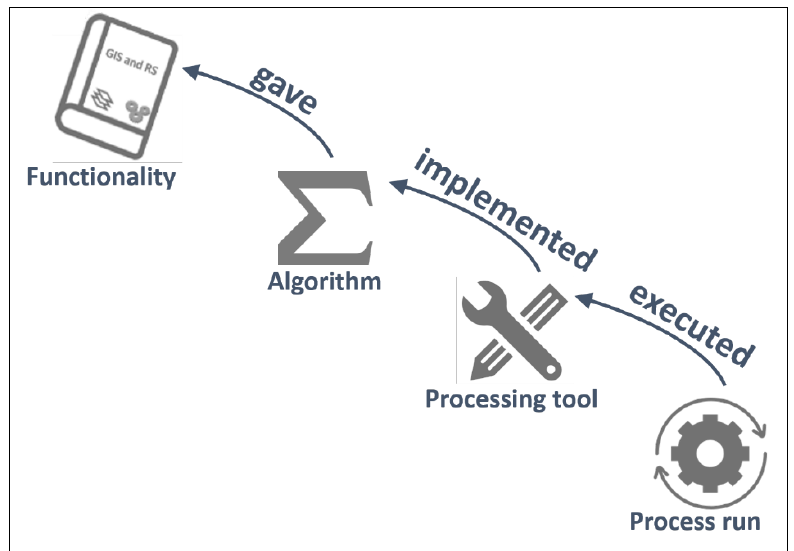
Figure 1. Representation of the four levels of process step abstraction.